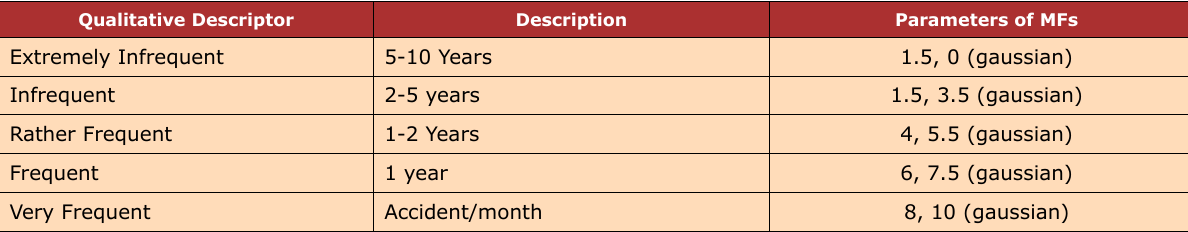
Table 2. Frequency of Occurrence/Probability of Accidents (FO)